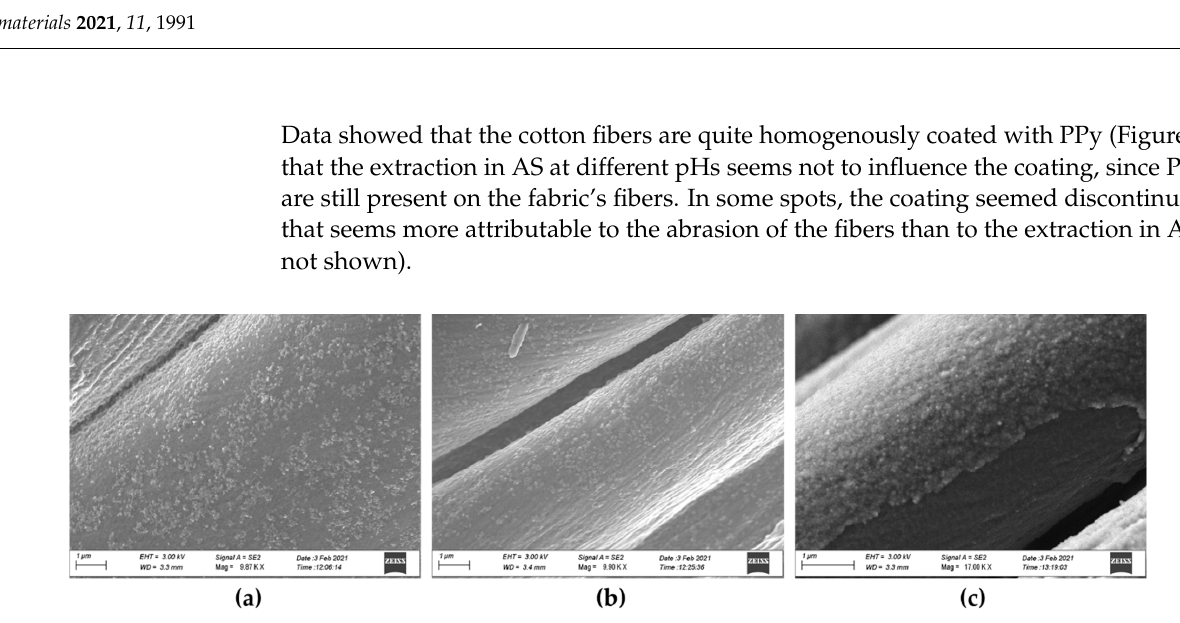
(AS); ( b ) PPy-coated fabrics after 72 h extraction in AS at pH 4.7; ( c ) PPy-coated fabrics after 72 h extraction in AS at pH 6.5.